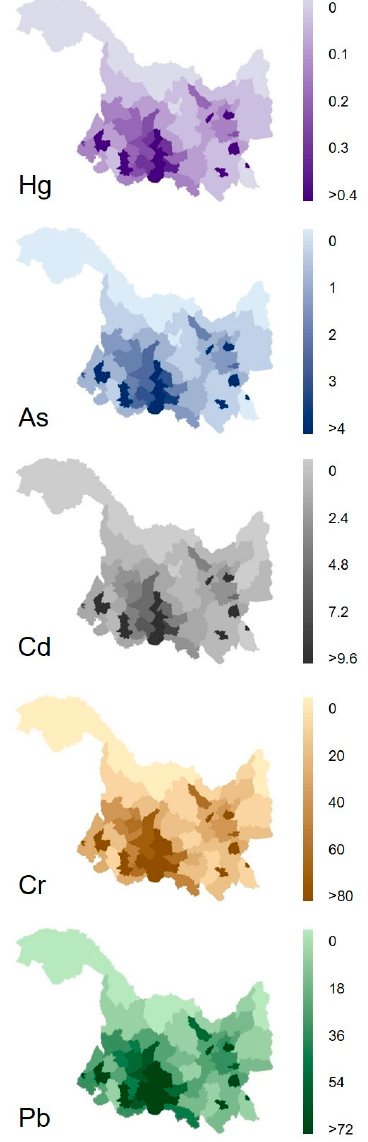
Figure 4. Distributions of five heavy metals released (g / km 2 · yr) from municipal wastewater in Heilongjiang province in 2017.